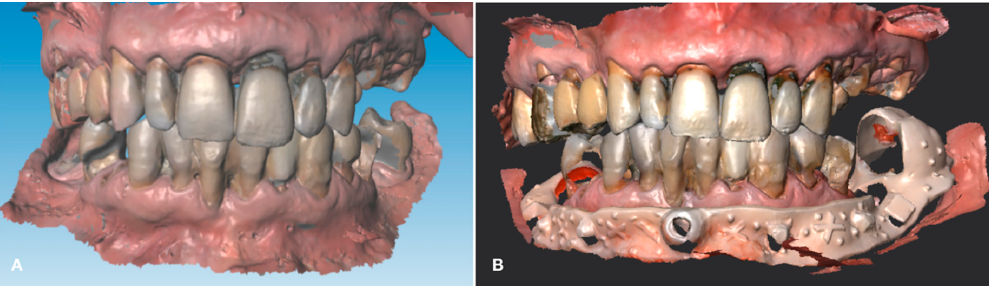
Figure 6. Frontal view of the three-dimensional relationship ( A ) between the maxillary and the mandibular digital im- pressions recorded during the first visit and ( B ) the lower presurgical scan superimposed over the lower impression.